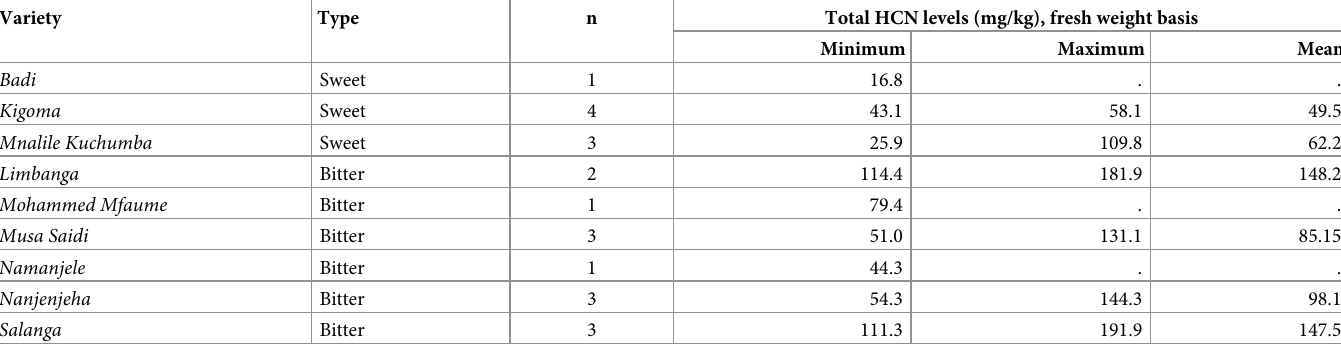
Table 4. Total hydrogen cyanide levels in fresh cassava roots of various cassava varieties cultivated in konzo-affected Mtwara region.